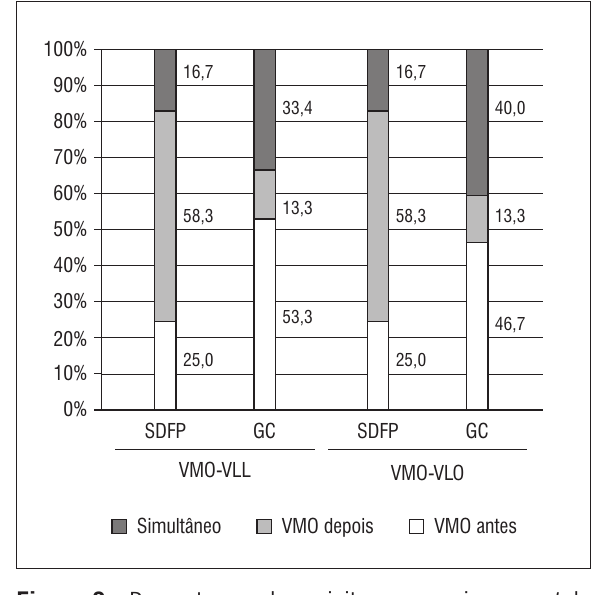
Figura 2 - Porcentagem dos sujeitos nos quais o onset do VMO ocorreu antes (10 ms antes), depois (10 ms depois) ou simultaneamente (até 10 ms) com o VLL e o VLO, no GC (n = 15) e SDFP (n = 12) Legenda: * = estatisticamente signi fi